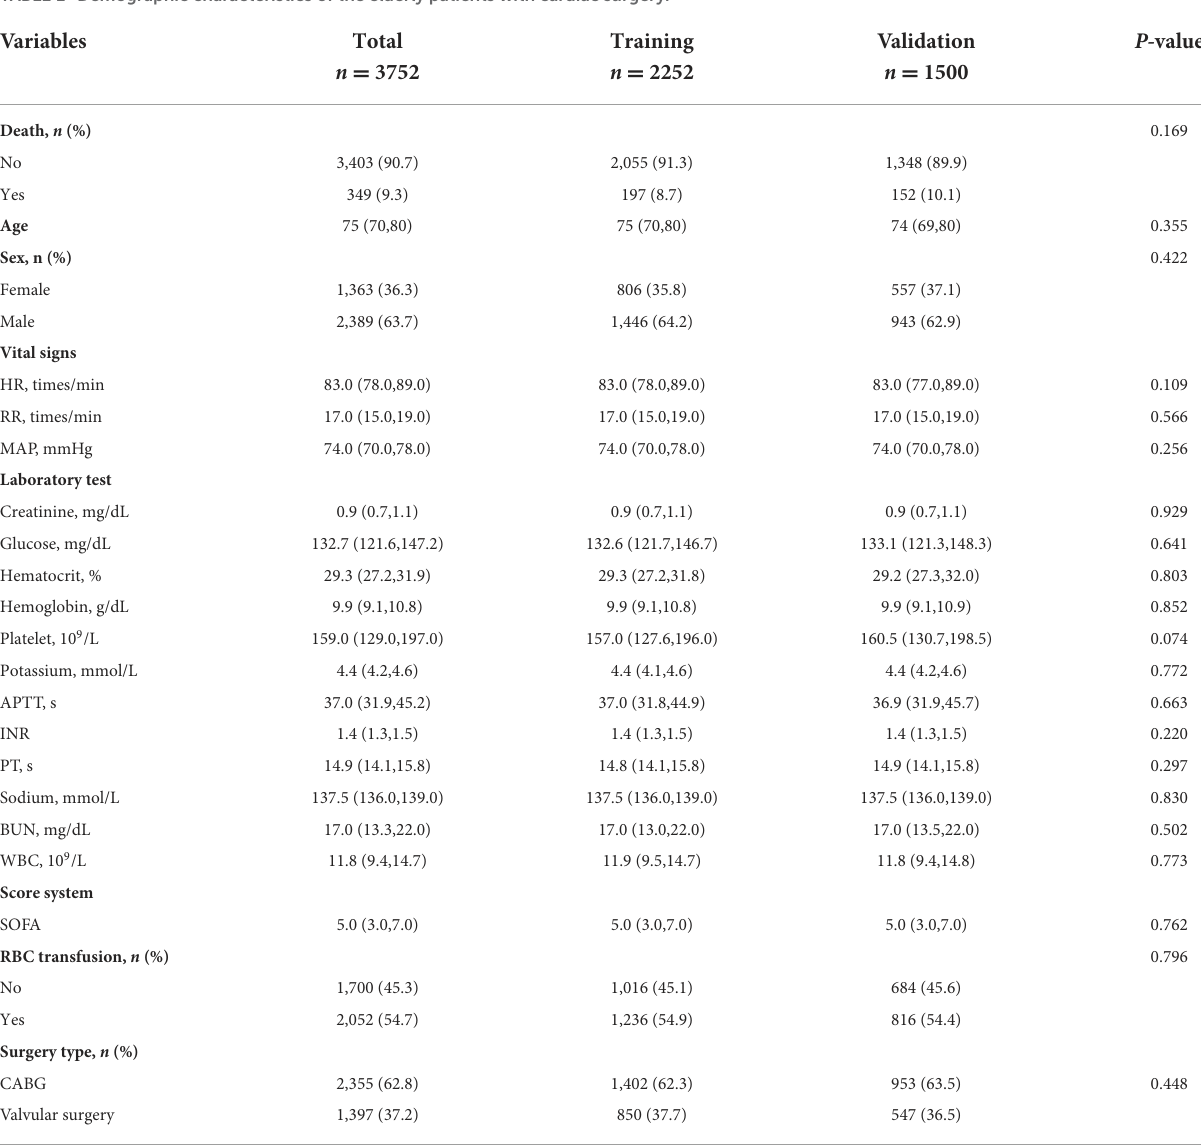
TABLE 1 Demographic characteristics of the elderly patients with cardiac surgery.